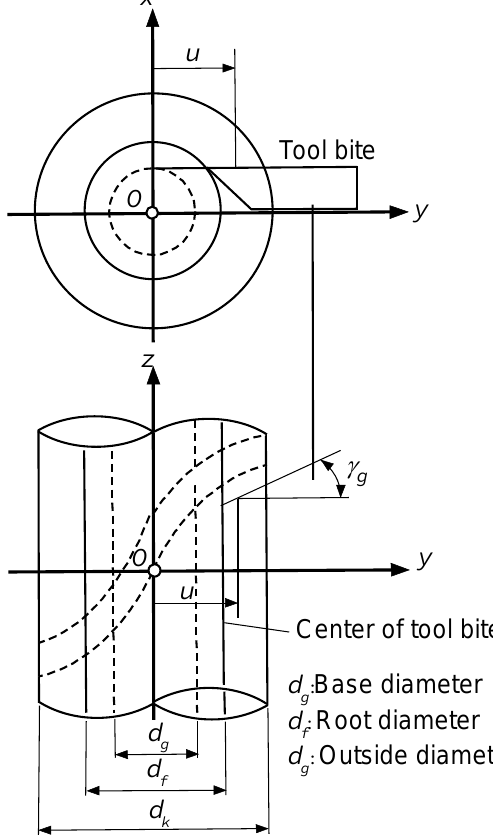
Figure 2. Parameters expressing tooth flank of worm of ISO Type